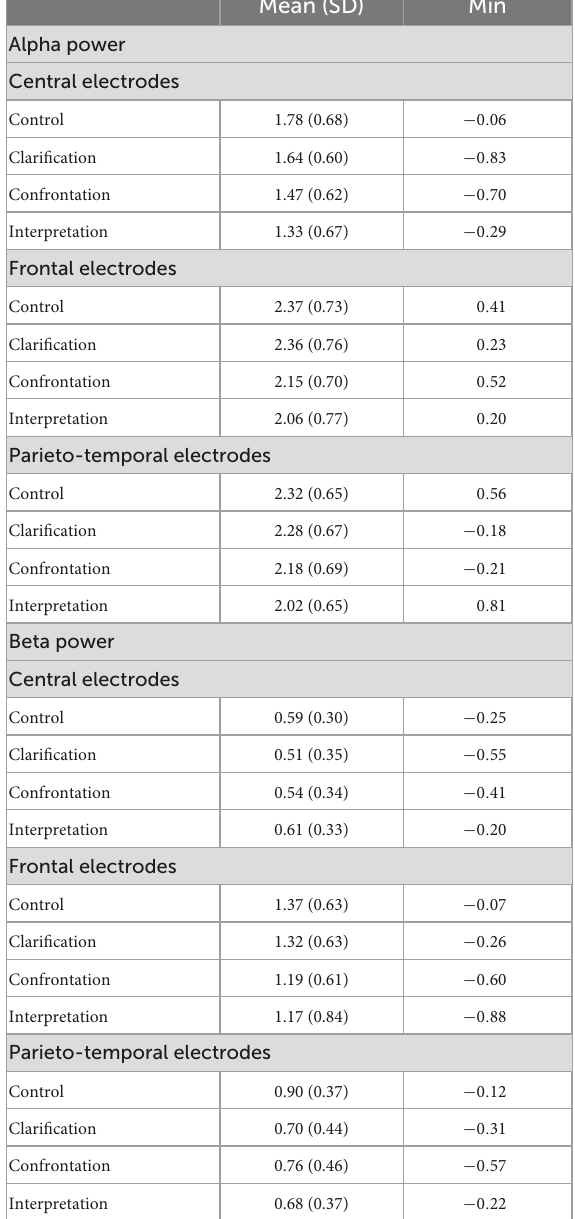
TABLE 1 Mean values, standard deviation (SD), min/max values, and subsegment counts (count seg.) of logarithms of alpha and beta power µ V 2 in the frontal (Fp1; Fp2), central (C3 and C4), and parieto-temporal (P3 and P4) electrodes (mean values averaged across subsegments for each